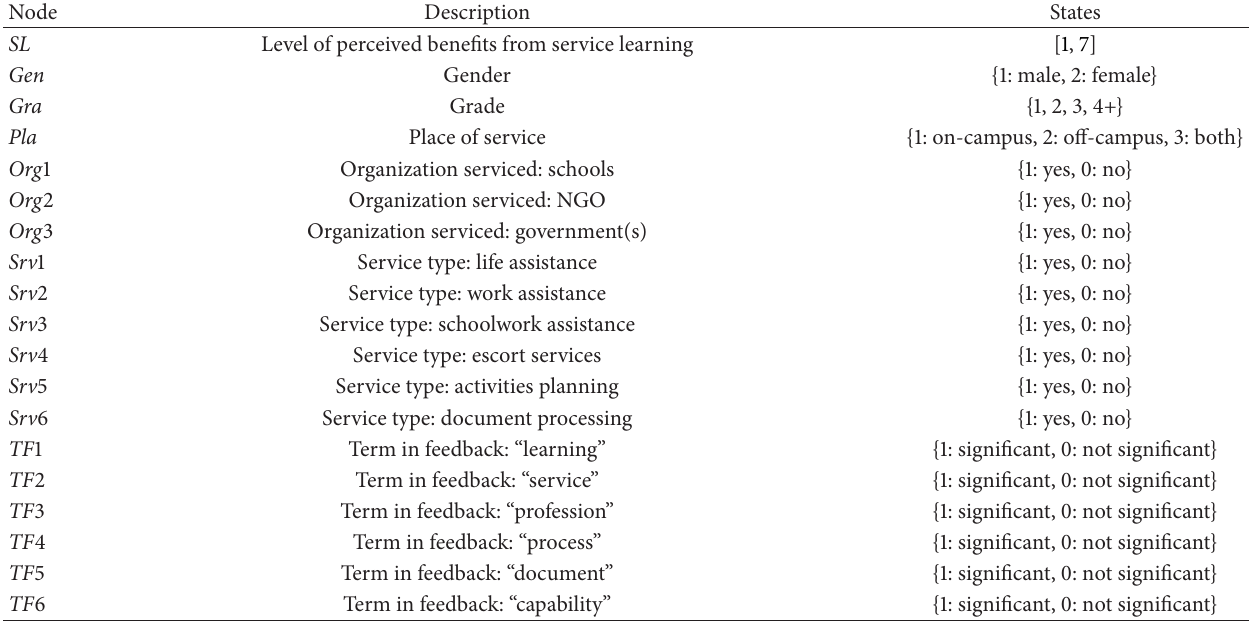
Table 4: Nodes of the Bayesian network on service learning.